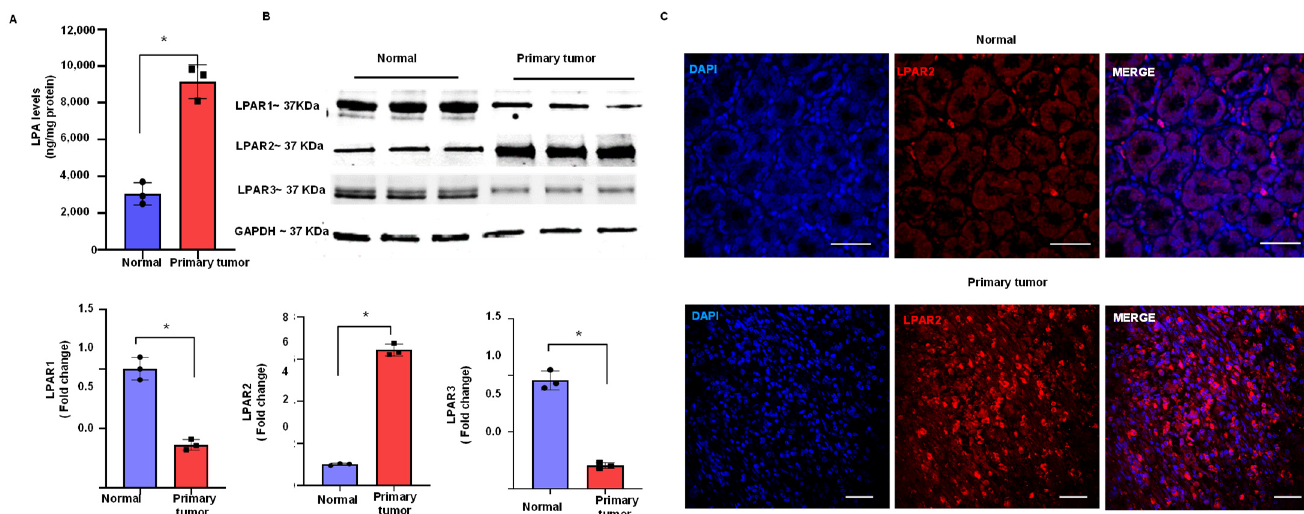
Figure 1. Upregulation of LPA and the LPAR2 receptor in human stomach cancer. ( A ) LPA ELISA immunoassay was performed in samples of the normal stomach (Normal) and stomach cancer (Primary tumor) tissue. ( B ) Upper panel: immunoblot analysis of LPAR1 ‐ 3 receptors in normal stomach and primary tumor tissue. We used GAPDH as a loading control. Lower panel: quantification of the Western blotting result. ( C ) Immunohistochemical analysis of LPAR2 in normal stomach and stomach cancer tissue sections (scale bar: 50 μ m). All values are mean ± SD ( n = 3). * p < 0.05 compared to normal stomach tissue using Student’s t ‐ test.